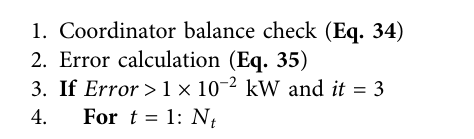
Algorithm 3. Application of Rule 3 ( Eq. 38 )